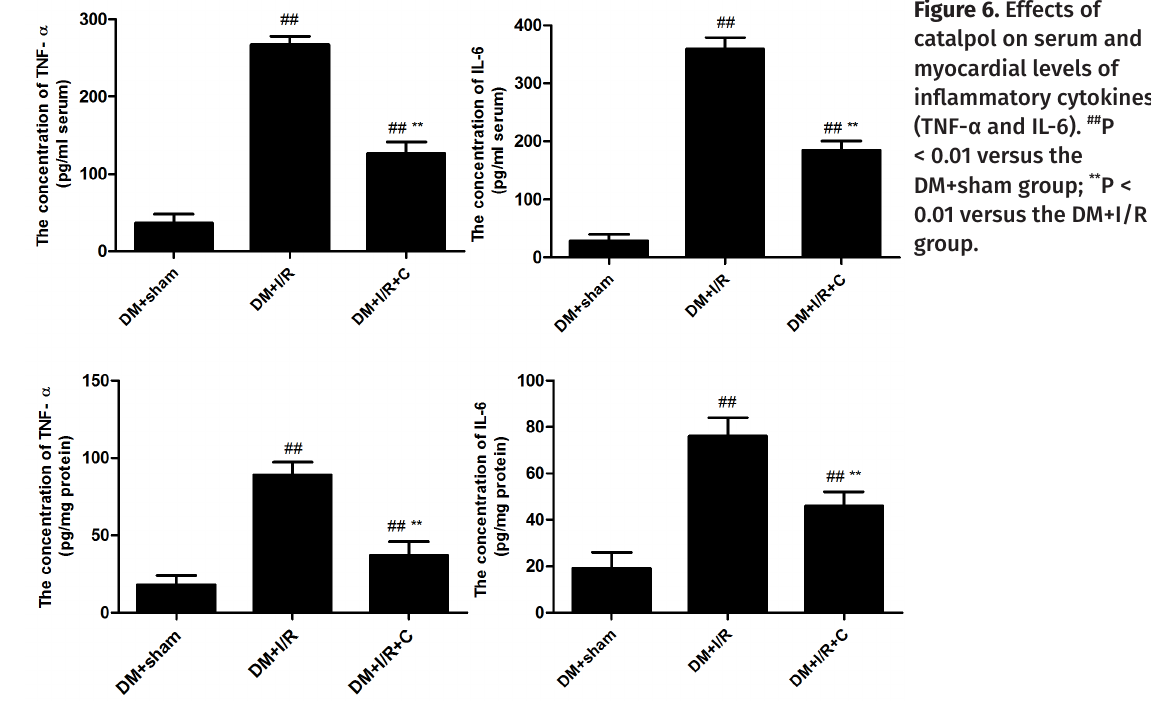
Figure 5. Effects of catalpol on myocardial oxidative stress. # P < 0.05 versus the DM+sham group. ## P < 0.01 versus